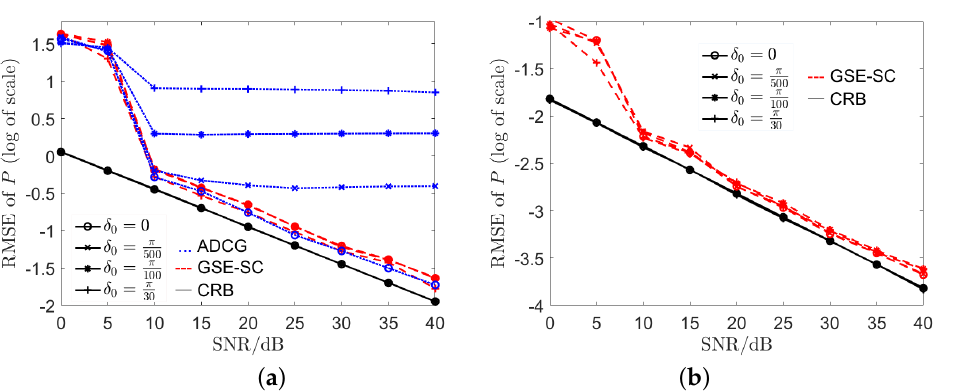
Figure 4. Simulation results of ADCG, GSE − SC, and CRB with different δ 0 . Since ADCG is not able to estimate δ , it is absent in the right subfigure. ( a ) RMSE of P ; ( b ) RMSE of δ . There are 12 and 8 lines in Figure 4a,b, respectively. We find that the CRB lines w.r.t. different δ 0 are very